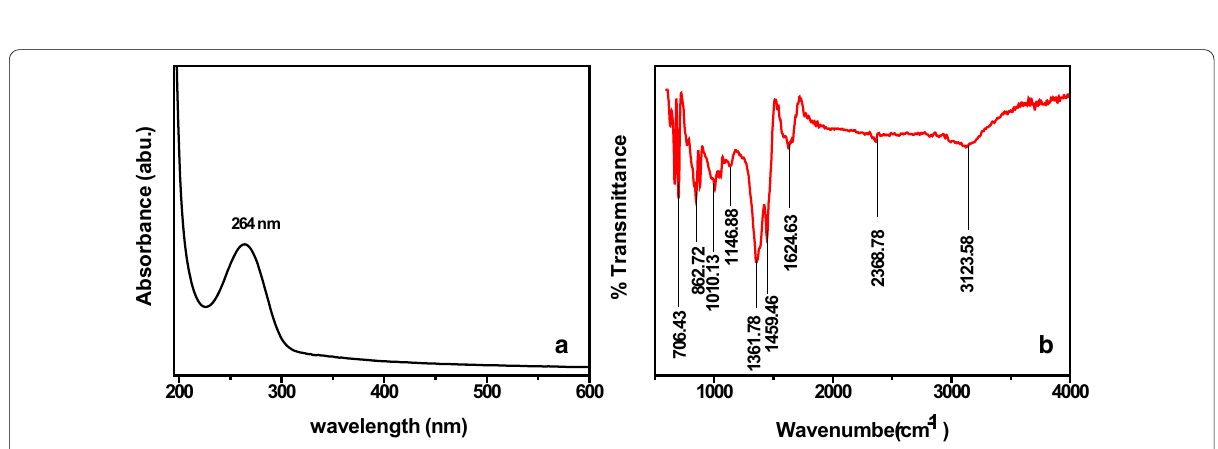
Fig. 5 a UV–visible spectrum and b FTIR spectrum, of the Kusha grass-derived as-synthesized activated carbon